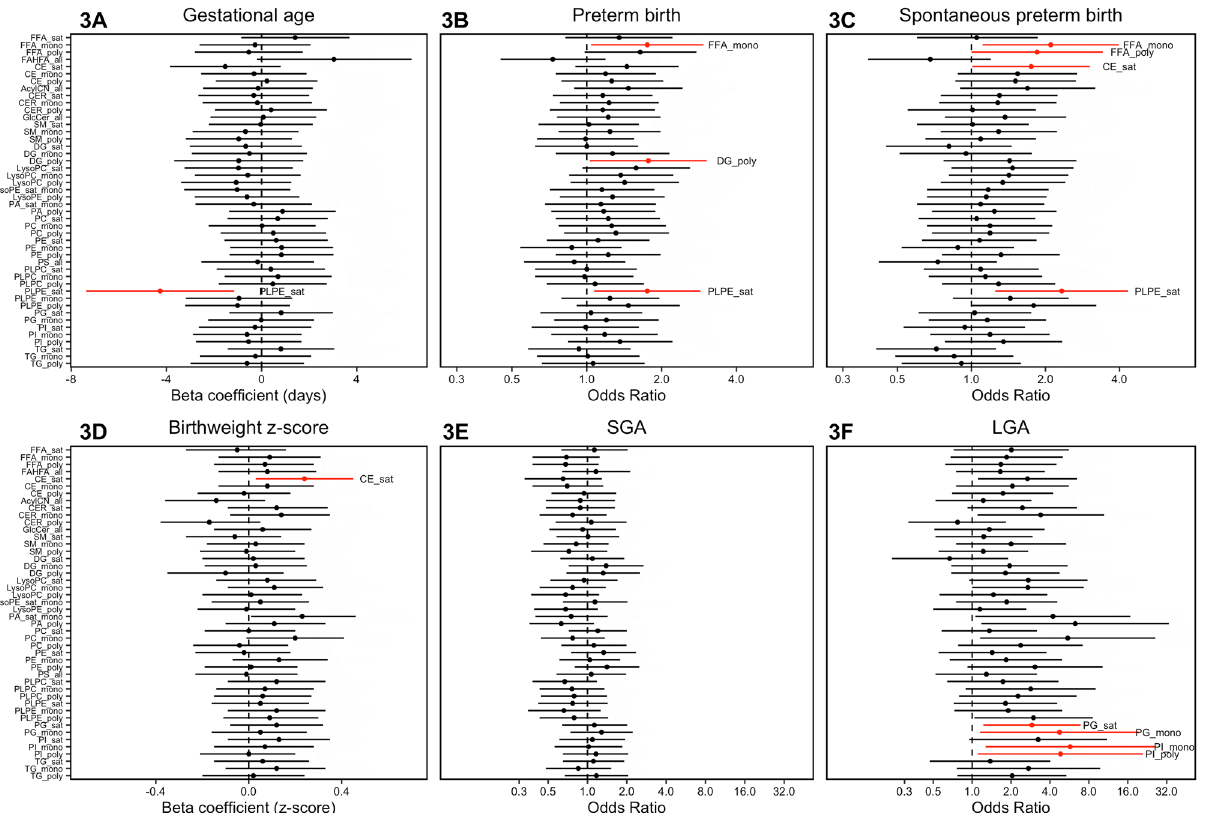
Figure 3. Forest plots of effect estimates of associations between hydrocarbon chain subgroups of lipid classes and pregnancy outcomes: ( A ) gestational age at delivery; ( B ) preterm birth (n cases = 31,n controls = 69); ( C ) spontaneous preterm birth (n cases = 19,n controls = 69); ( D ) birthweight z-score; ( E ) small for gestational age [SGA] (n cases = 16,n controls = 75); ( F ) large for gestational age [LGA] (n cases = 9,n controls = 75). Models adjusting for maternal age, maternal education, fetal sex, pre-pregnancy BMI, and weight gain. Associations highlighted in red have p-values < 0.05, but all associations had corresponding q-values exceeding